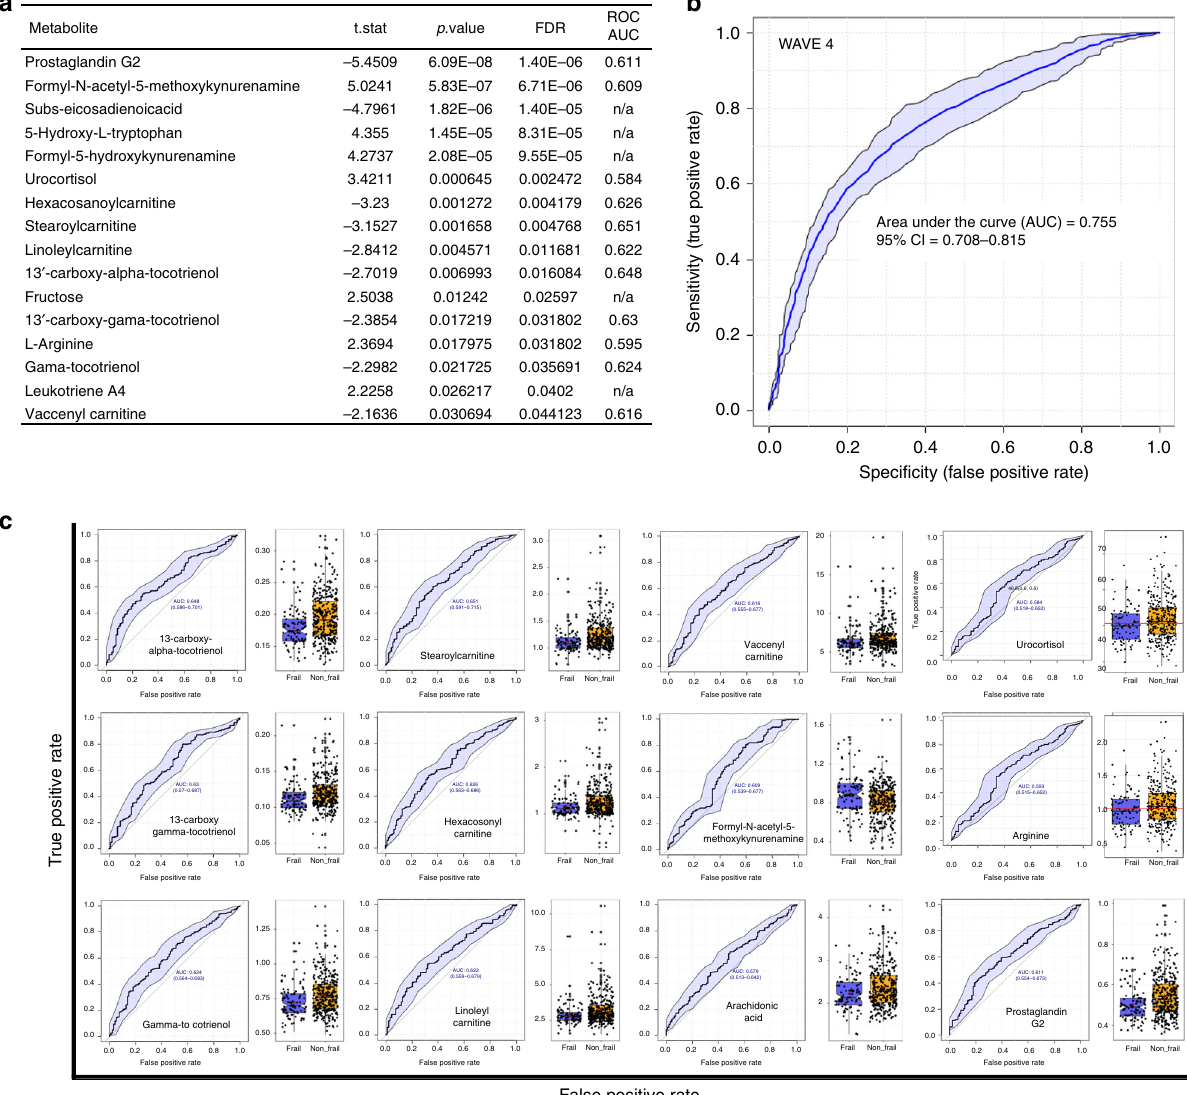
Fig. 5 Signi fi cance and predictive ability within the metabolic model of frailty. a Table indicating 12 metabolites of statistical signi fi cance ( p < 0.05) in differentiating non-frail and frail metabolic phenotypes using Kruskal-Wallis analysis of variance with subsequent false discovery rate testing for multiple comparisons. Data also contains area under curve data used to create multivariate receiver operating characteristic curve (mROC) b mROC curve from Waves 4 generated by combining 12 metabolites to generate a predictive model of frailty status. The shaded area indicate 95% con fi dence intervals calculated by Monte Carlo cross validation using balanced subsampling and 1000 iterations of bootstrapped cross-validation. c Univariate ROC curves and non-frail (orange) to frail (blue) boxplots of each metabolite used to generate the multivariate ROC analysis. Each boxplot displays a median value (centre line), upper and lower quartiles (box limits), 1.5× interquartile range (black bar), and points out of interquartile range are outliers. Source data are provided as a Source Data fi